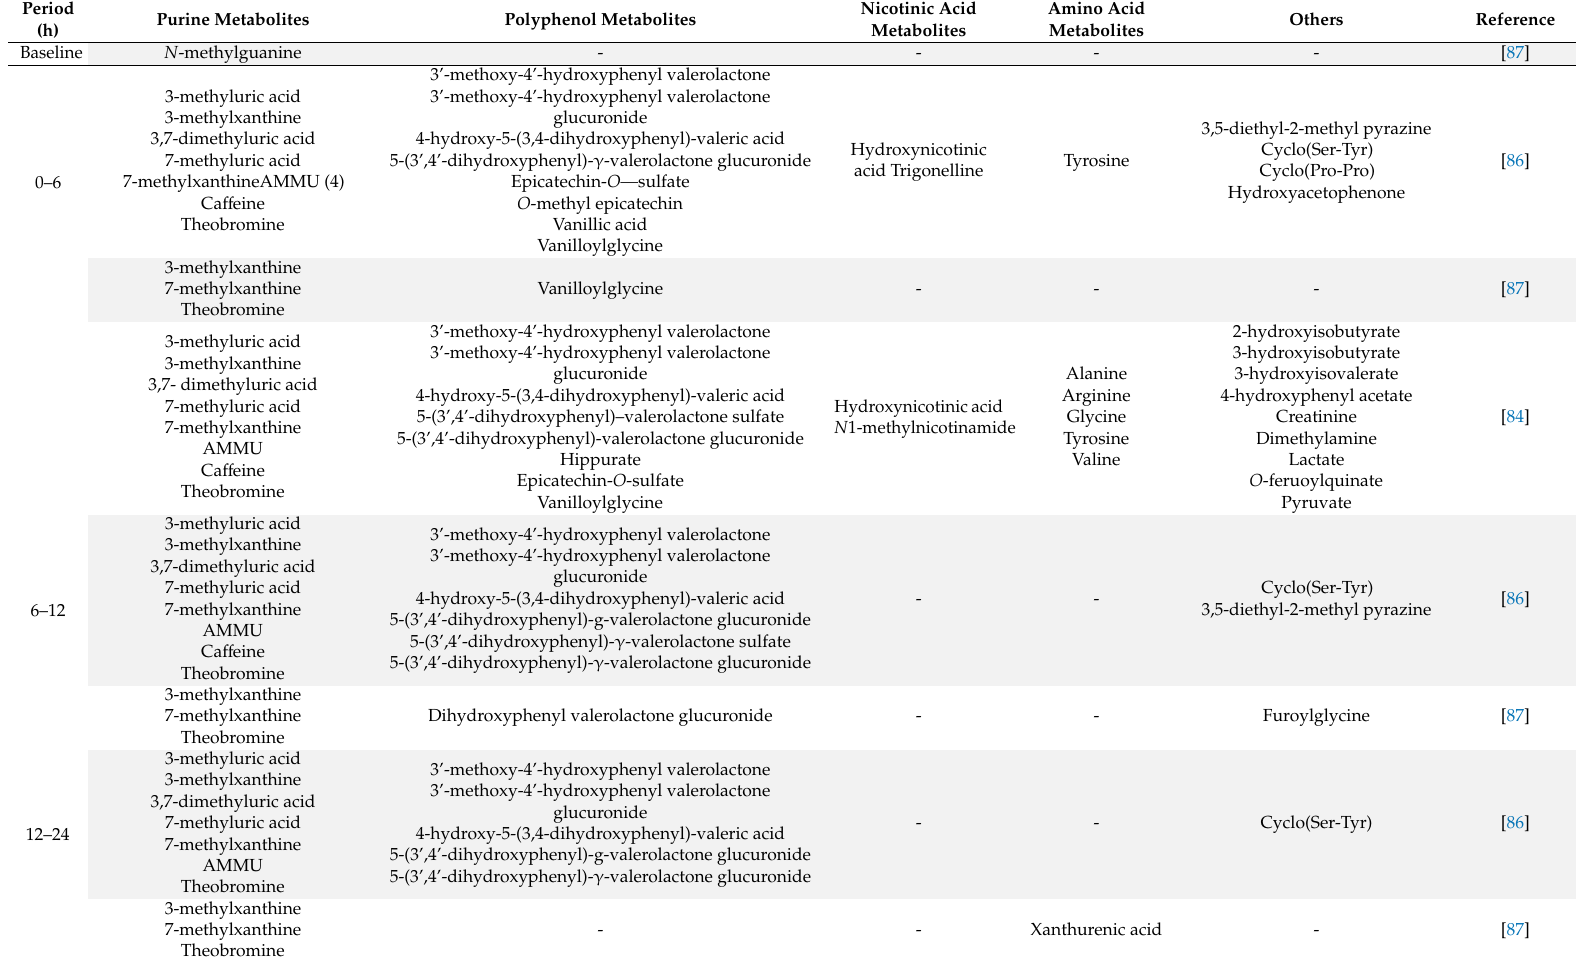
Table 7. Metabolites analyzed in urine after acute cocoa intervention studied with non-targeted